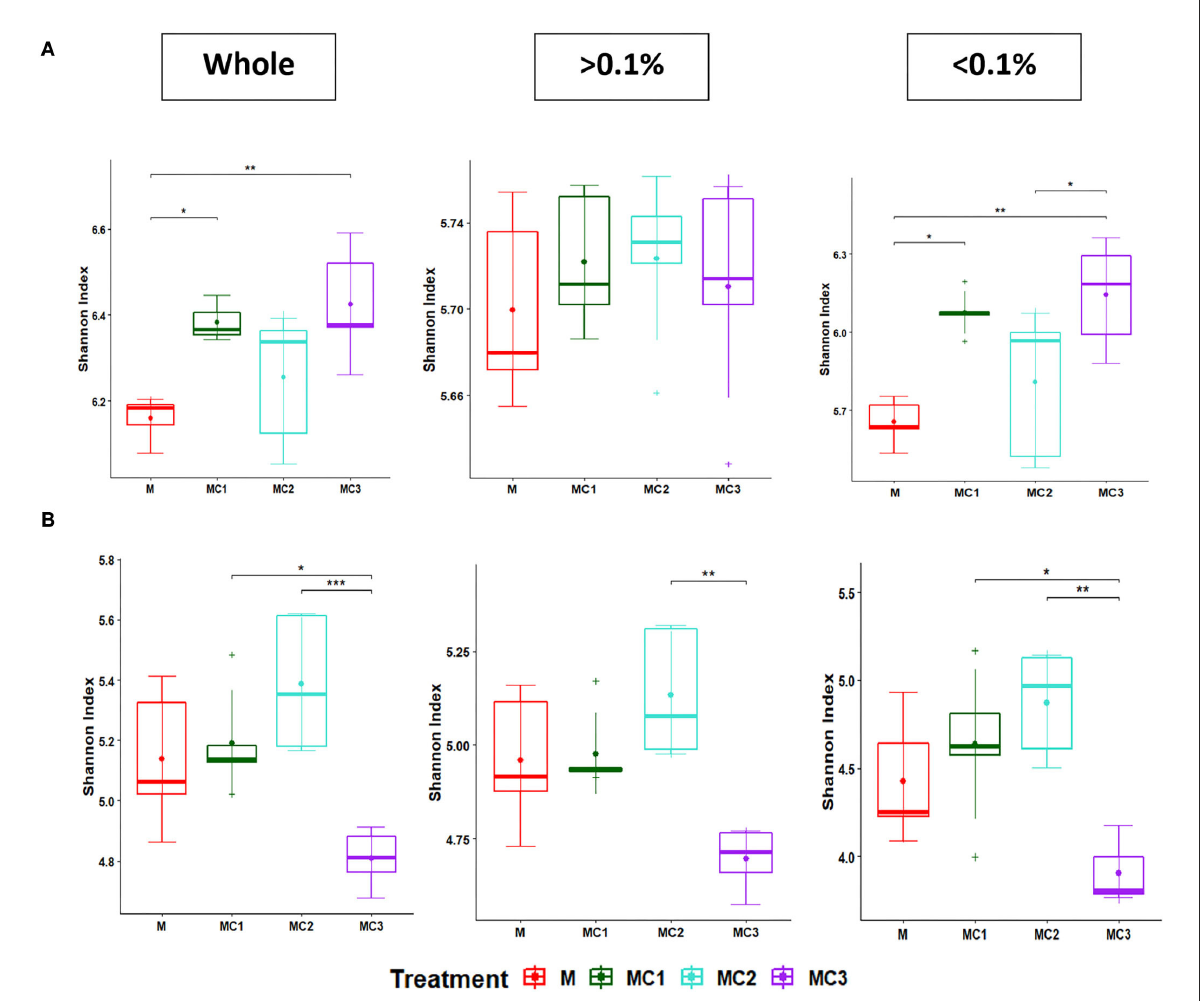
FIGURE2 Boxplot of Shannon diversity index of the whole, more abundant, and rare bacterial taxa at the first (A) and third (B) years under the cropping systems. The “ • ” and line inside the box plot respectively represent the mean and median, ( n = 5). “ + ” outside the box plot are outliers. Significant differences between cropping systems (Kruskal–Wallis test followed by post-hoc ) are indicated by “*”, < 0.05: “**”, < 0.01; “***”, < 0.001. The “ > 0.1%” represents the abundant taxa; “ < 0.1%” represents the rare taxa; whole, total. M, melon monocrop; MC1, mixed intercropping; MC2, intercropping row 1:1 melon:cowpea; MC3, intercropping row 2:1